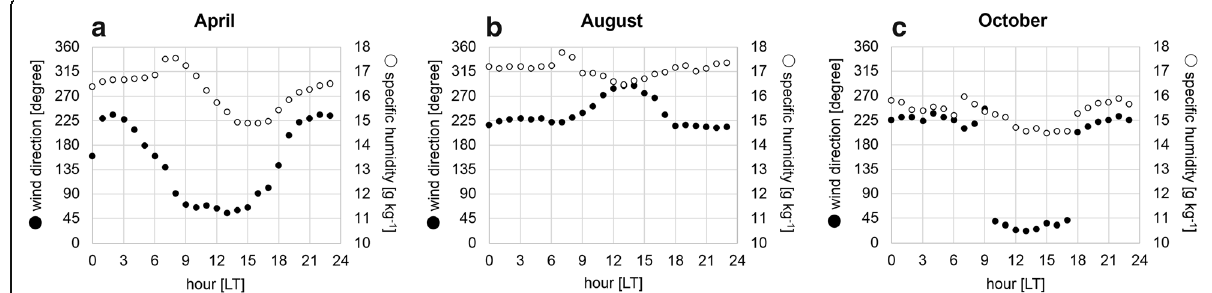
Fig. 9 Diurnal patterns of wind direction (filled circles) and specific humidity (open circles) observed at the AWS at S7 (Fig. 2) in April ( a ), August ( b ), and October ( c ) as 6-year monthly